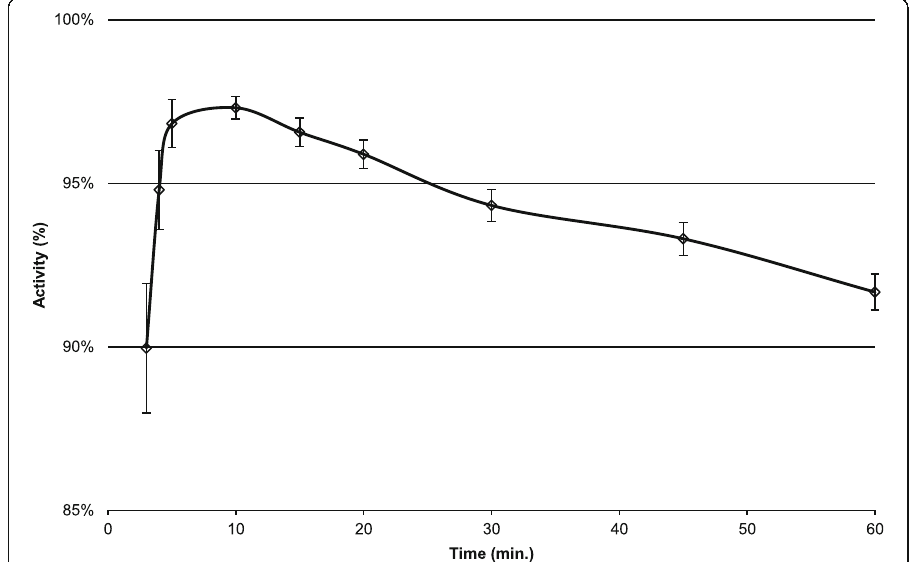
Fig. 1 Relative plasma activity in the first hour after administration of rHSA (Tmax is 100% activity for each individual